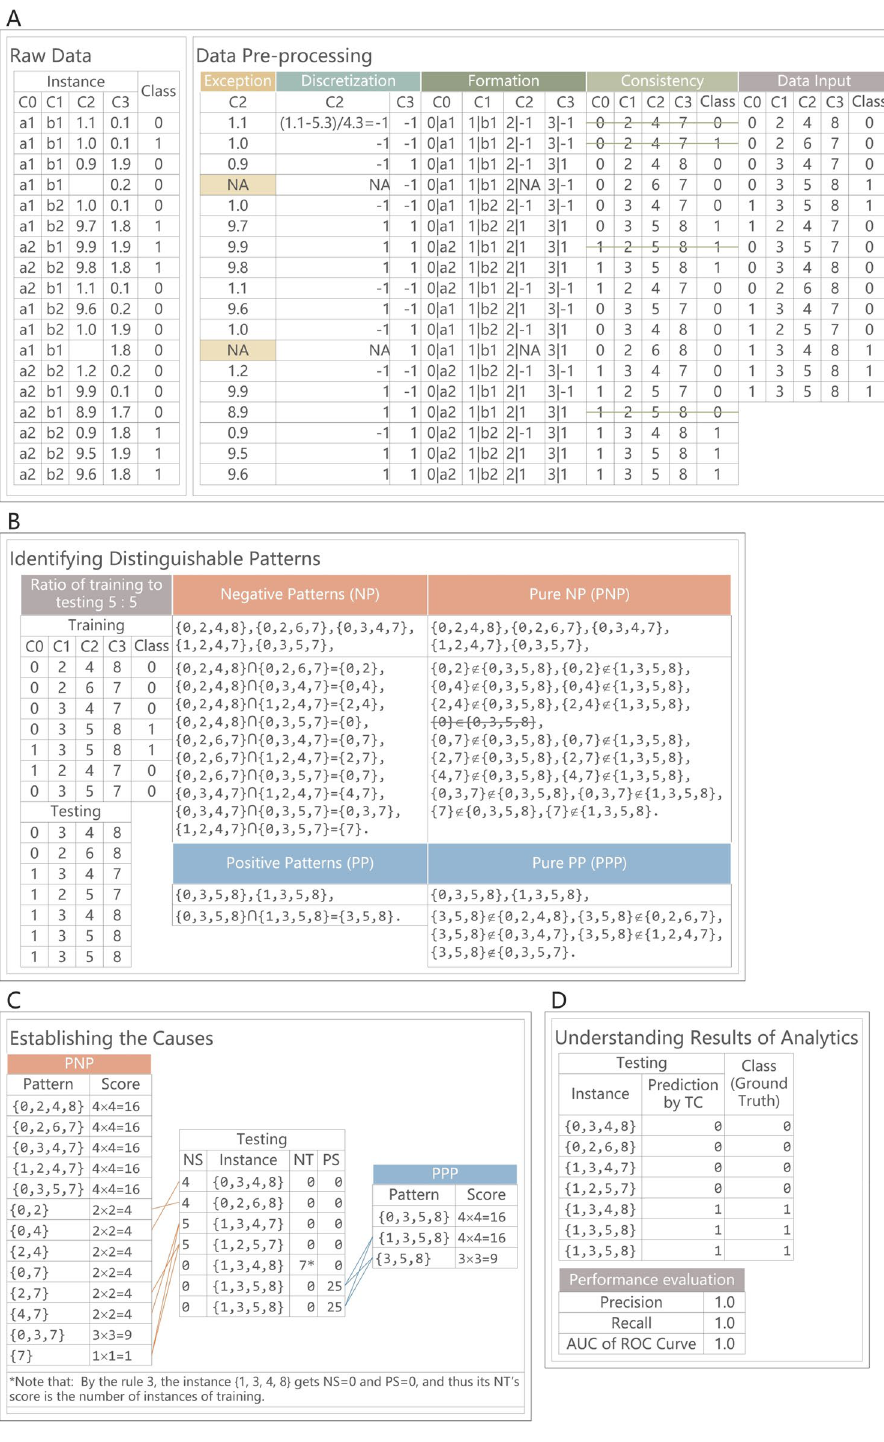
Figure 4. Illustration of TC: a step-by-step